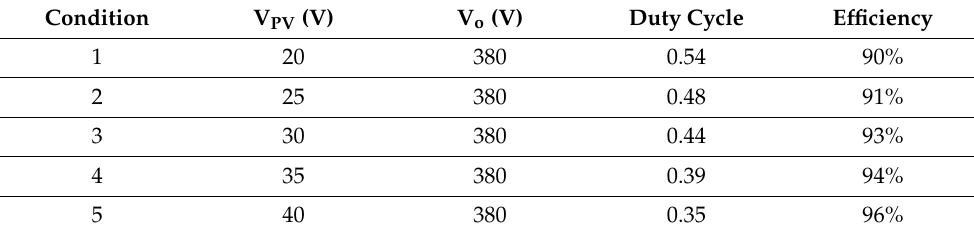
Figure 20. Experimental waveform for the gate source voltage (V GS ), solar photovoltaic simulator output voltage (V PV ), and output voltage (V o ) for the proposed HVGSU converter at the 0.35 duty cycle (Hor: 20 µs/div).